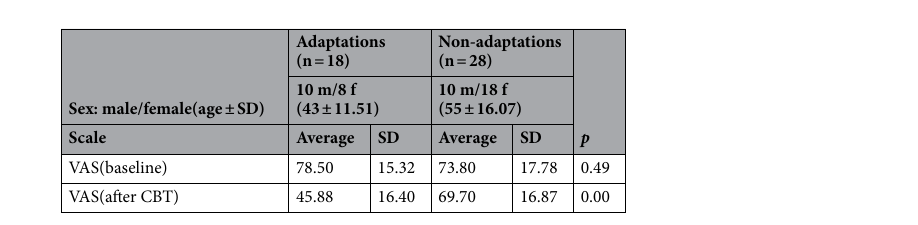
Table 4. VAS value after the CBT